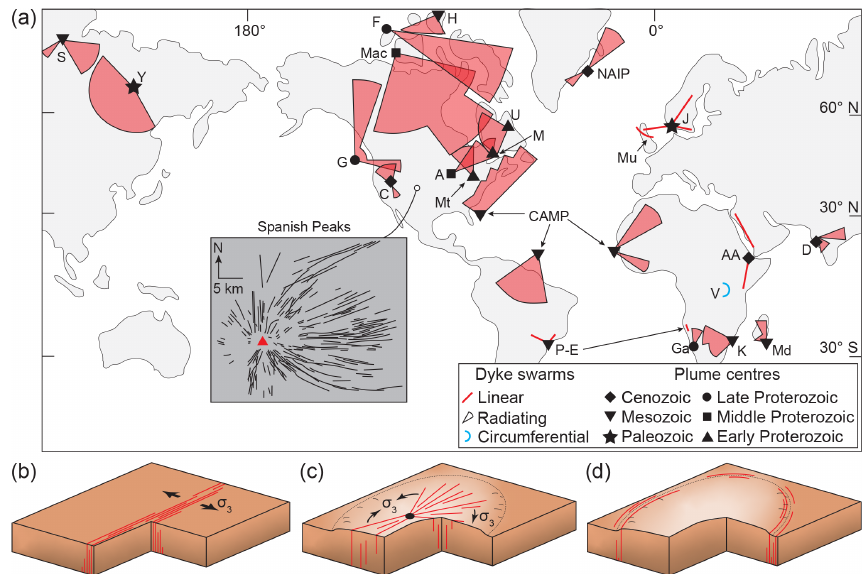
Figure 1. (a) Map of the major dyke swarms on Earth, highlighting their form and age of associated mantle plume sources if relevant (modified from Ernst, 2014; Magee et al., 2019). Dyke swarms shown include A = 1140Ma Abitibi swarm, precursor to the 1115–1085Ma Keweenawan LIP; AA = 30–0Ma Afar-Arabian swarms; C = 17–0Ma Columbia River swarms; CAMP = 201Ma Central Atlantic Mag- matic Province swarm; D = 66Ma Deccan swarm; F = Franklin swarm; G = 779Ma Gunbarrel swarms; Ga = 799Ma Gannakouriep swarm; H = 130–90Ma High Arctic LIP (HALIP) swarm; J = 301Ma Skagerrak (Jutland) swarms; K = 183Ma Karoo swarms; M = 2510Ma Mis- tassini swarm; Mac = 1267Ma Mackenzie swarm; Md = 89Ma Madagascar swarm; Mt = 2480–2450Ma Matachewan swarm; NAIP = 62– 55Ma North Atlantic Igneous Province swarms (e.g. Mu is the Mull dyke swarm); P-E =∼ 135–128Ma Paraná-Etendeka dyke swarms; S = 251Ma Siberian Traps swarm; U = 2217–2210Ma Ungava swarm; Y = 370Ma Yakutsk-Vilyui swarm. Inset: map of the radial dyke swarm around the Spanish Peaks volcanic centre (redrawn from Odé, 1957). (b–d) Schematic diagrams depicting parallel/linear (b) , radiat- ing (c) , and circumferential (d) dyke